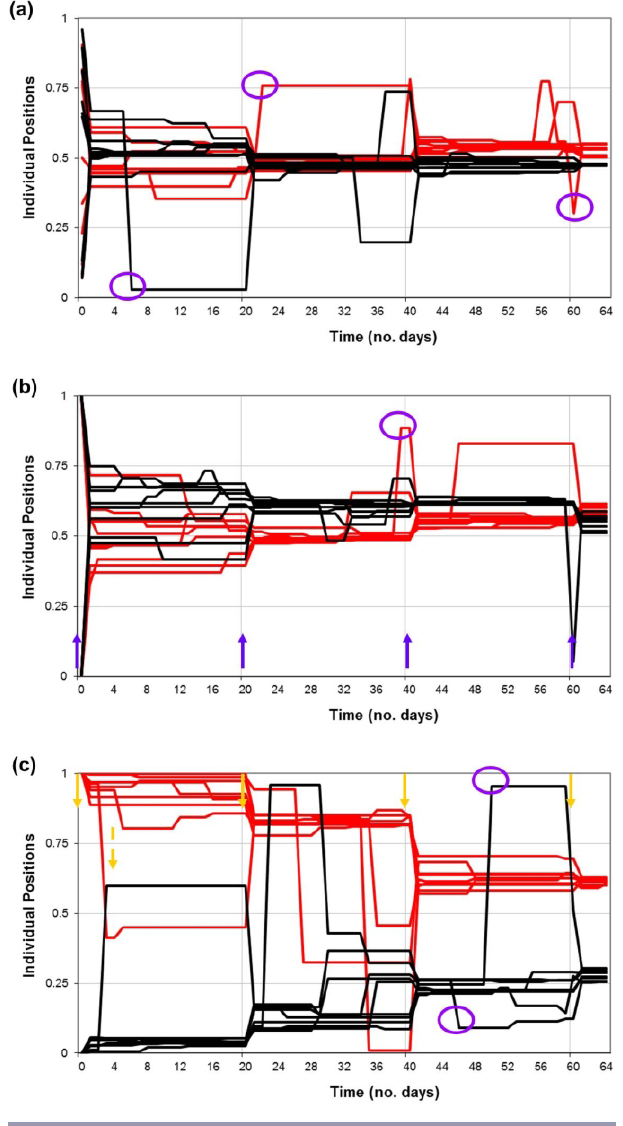
Fig. 8 . Evolution of individual positions in two groups across polarization scenarios with a 10% mutation rate: (a) no polarization, (b) intragroup polarization, and (c) intergroup polarization. Purple circles show examples of mutation. Yellow arrows indicate intergroup interactions and purple arrows indicate intragroup interactions. Solid arrows show formal interactions and dashed arrows show informal interactions. (Note: only some meetings are